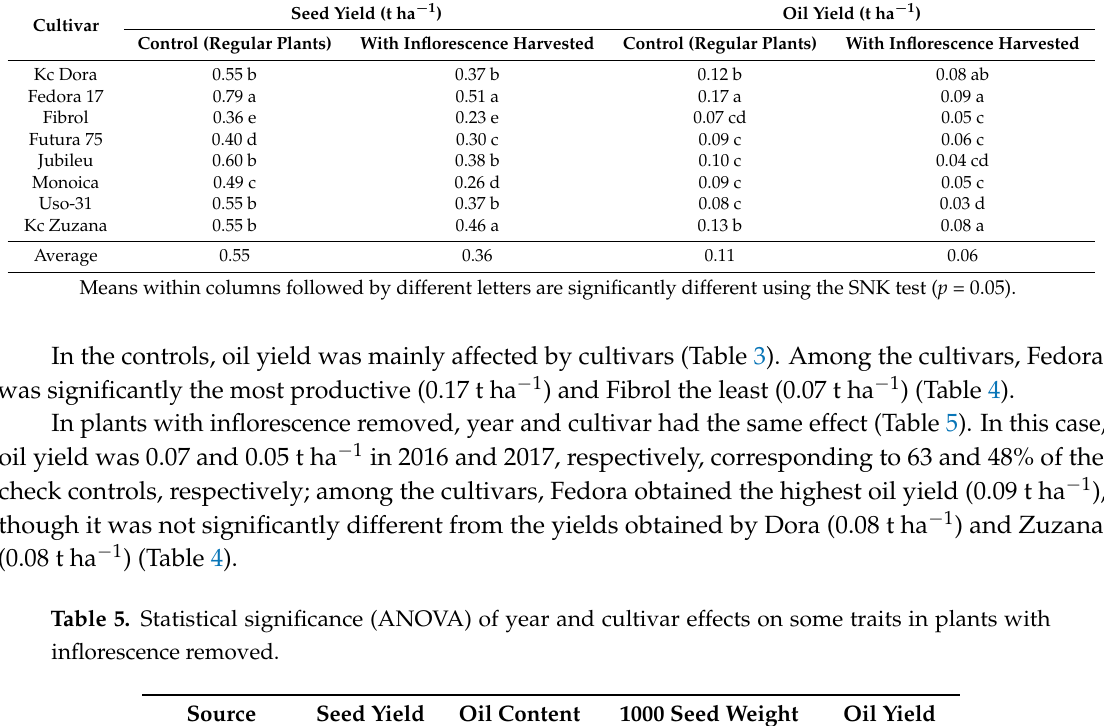
Figure 7. Seed yield of the control plants of cultivars studied (KCD = KC Dora; FED = Fedora 17; FIB = Fibrol; FUT = Futura 75; JUB = Jubileu; MON = Monoica; USO = Uso-31; ZUZ = Zuzana). Means followed by the same letter are not significantly different (SNK at the 5% level). Error bars are standard deviations. Table 4. Oil and seed yield of hemp cultivars studied (control) and of the same plants with inflorescence harvested at flowering. Results are means.